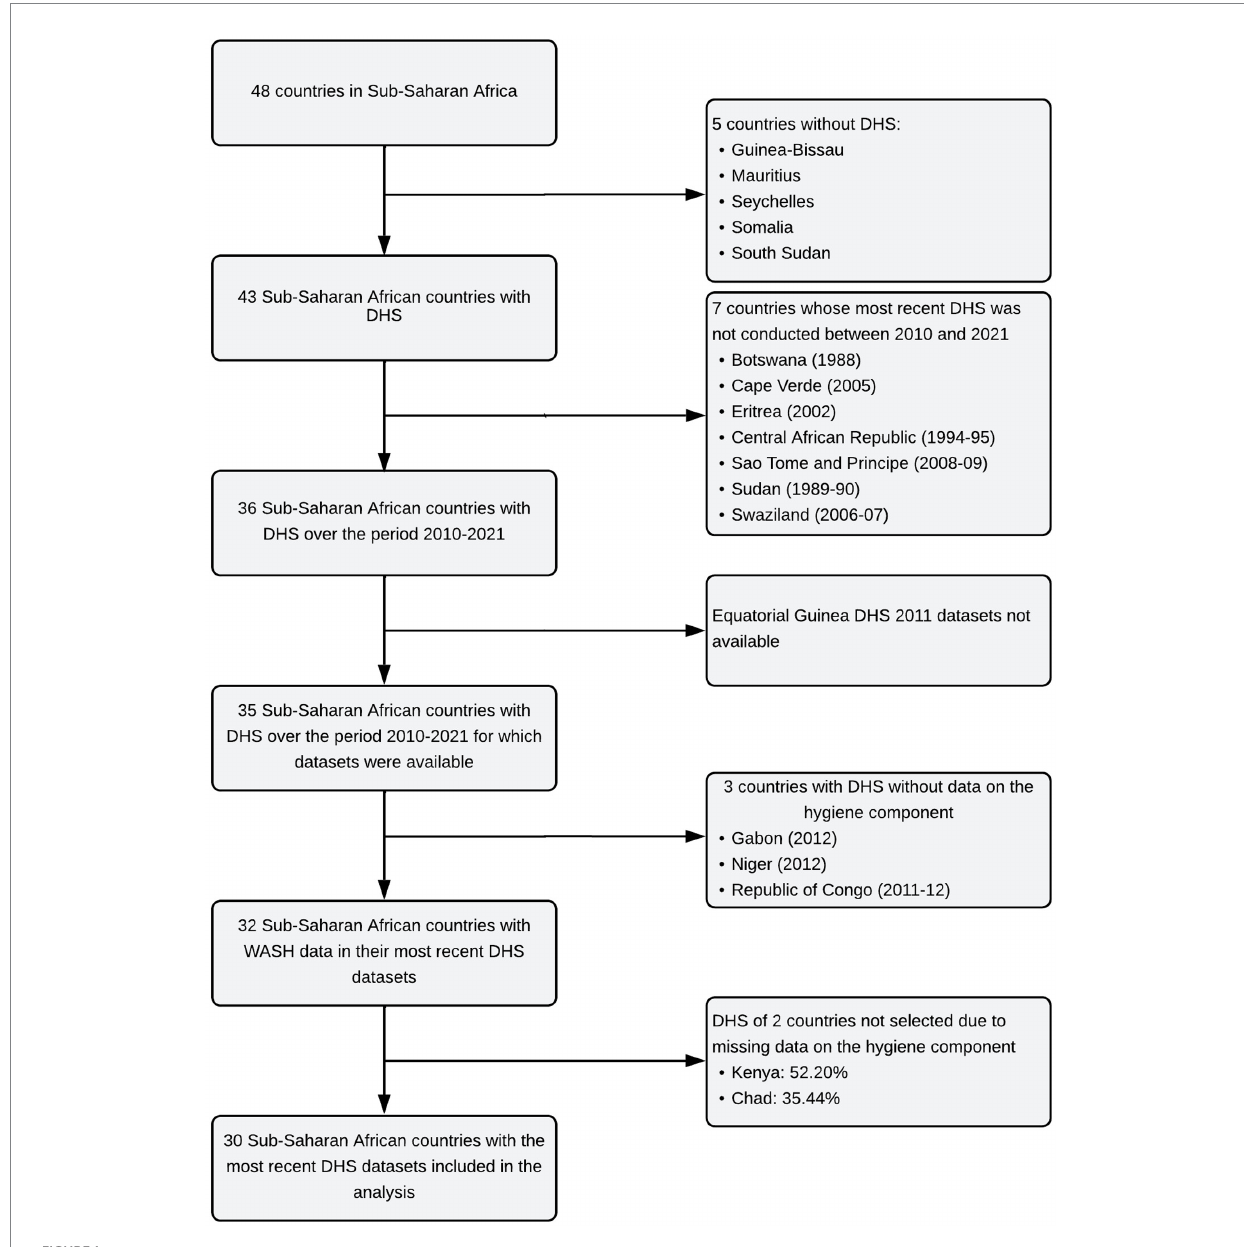
FIGURE 1 Flowchart for the selection of national